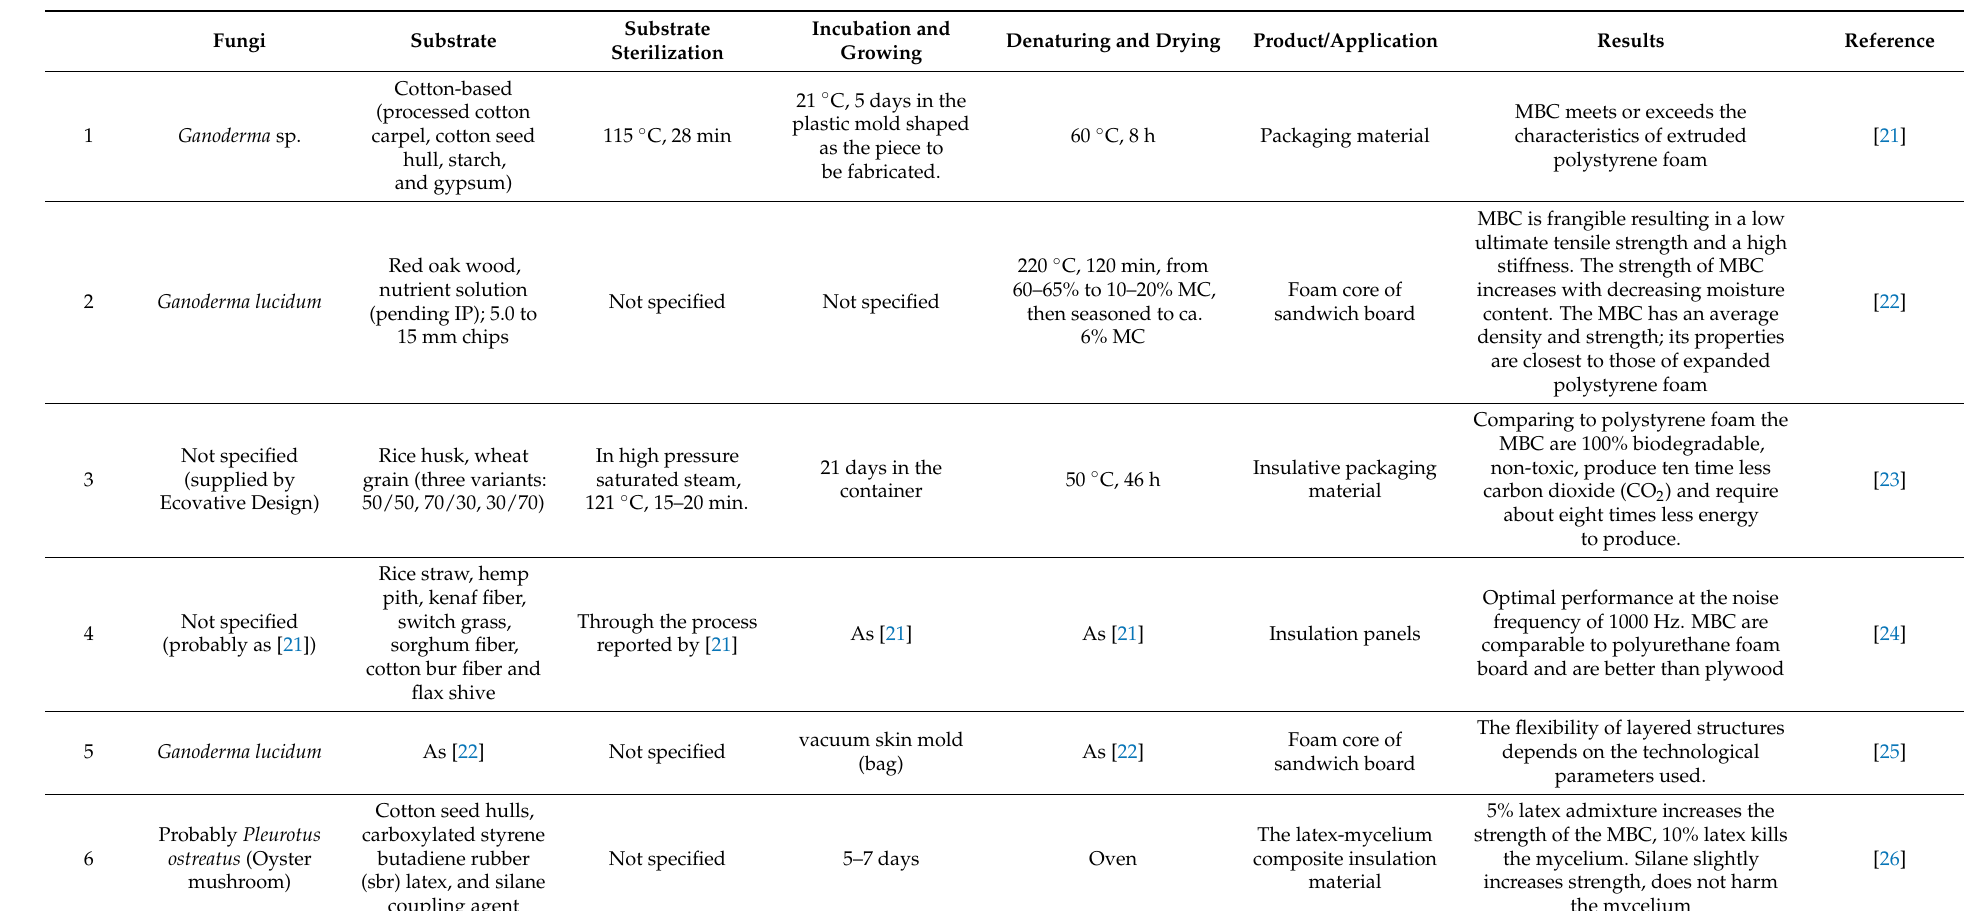
Table A1. A systematic review of fungus species, growth parameters, and main results in the scientific